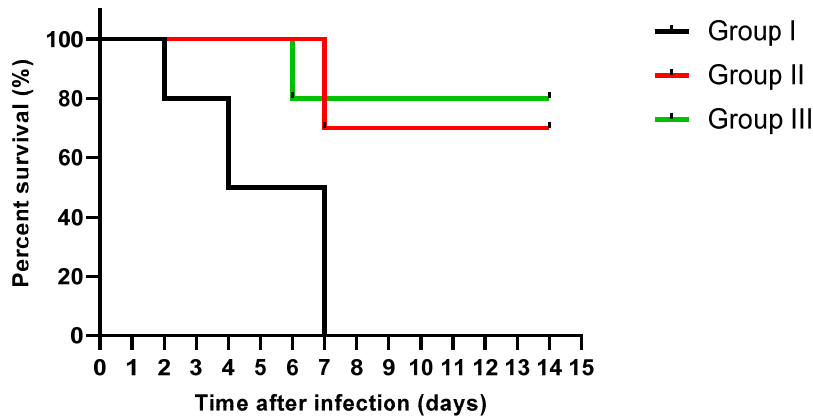
Figure 7. Survival curve of rats of the different groups via Kaplan–Meier survival analysis. Table 3. Blood urea and serum creatinine levels in the tested groups. Measured Parameter